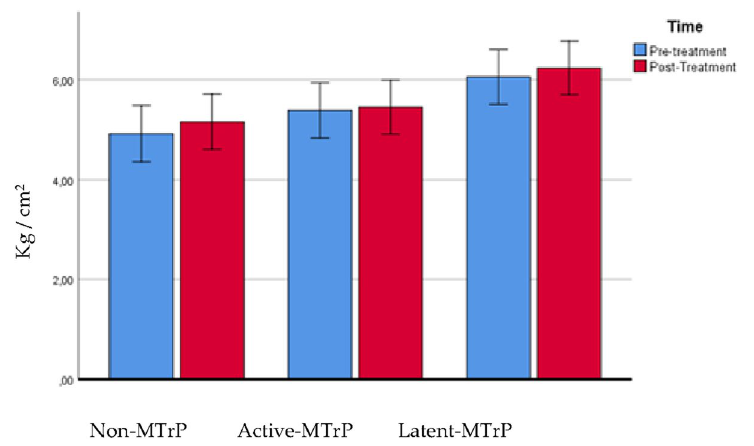
Figure 3. PPT trapezius muscle.